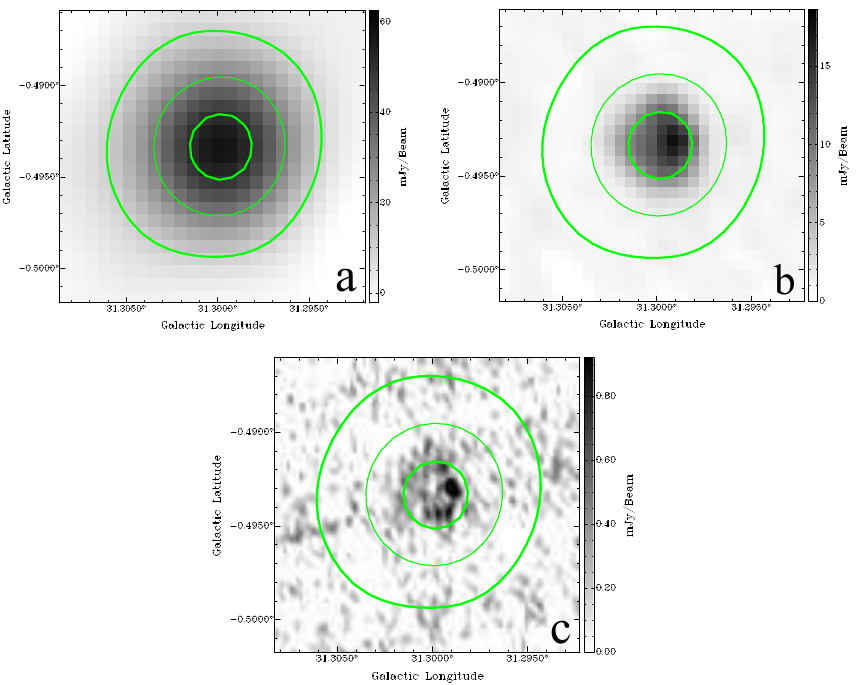
3.3.2. SNR G31.299 − 0.493 G31.299 − 0.493 is ∼ 20 (cid:48)(cid:48) (Figure 5a) in size. The 1.4 GHz MAGPIS image (Figure 5b) shows the diameter of the SNR to be ∼ 20 (cid:48)(cid:48) and significantly larger than the synthesized beam of 6.2 (cid:48)(cid:48) × 5.4 (cid:48)(cid:48) . This diameter is consistent with the shell-like structure seen in the 6 cm MAGPIS image (Figure 5c).